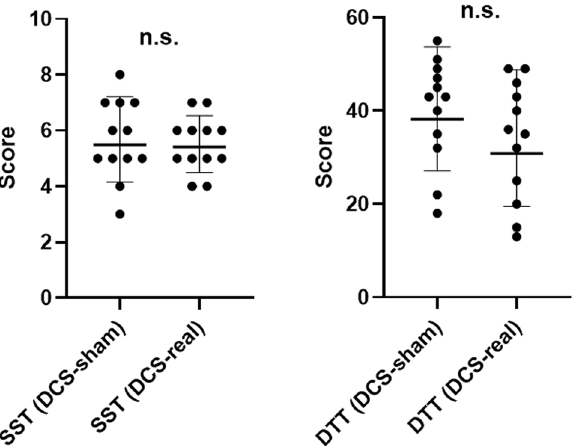
Figure 3. Dot plots representing the participants’ performance for the cognitive behavioral assessment (SST: Spatial span task; DDT: Double trouble task).